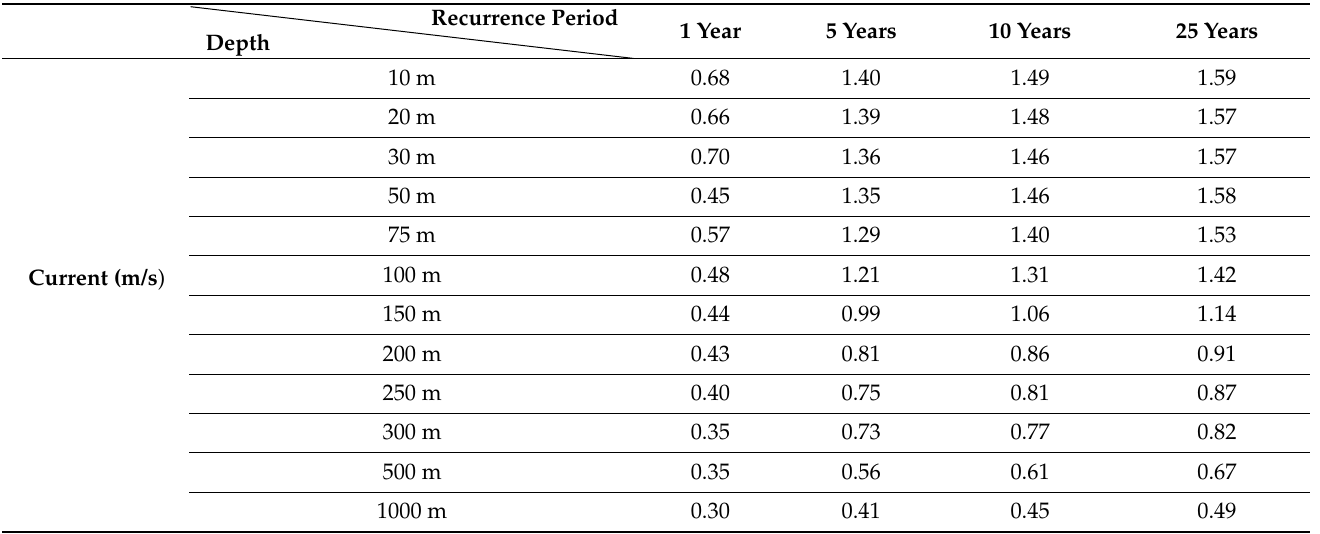
Table 1. Environmental parameters of the regional